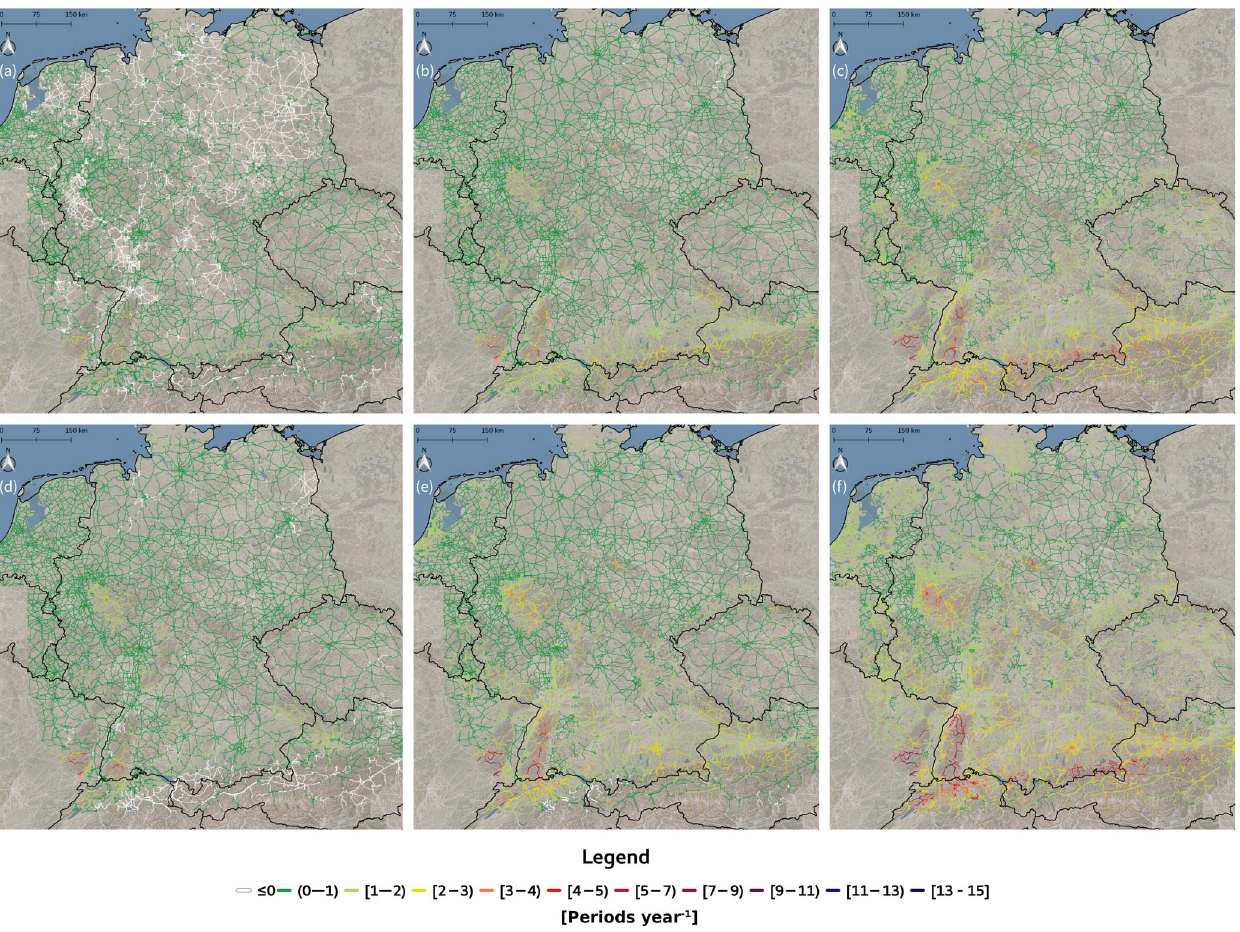
Figure 1. Projected changes in the annual number of periods exceeding rainfall thresholds for the possible occurrence of landslides (precip- itation totals > 25.6mmd − 1 and > 37.3mm(3d) − 1 ) concerning the high-level road network in central Europe. The first row (a–c) shows near-future projection results and the second row (d–f) displays projection results for the remote future. The three columns represent the quartiles in increasing order, with (a) and (d) displaying the lower quartile, (b) and (e) displaying the median and (c) and (f) displaying the upper quartile Table 1. Summary statistics for the six different facets displayed in Figs. 1 and 2 based on all raster cells covering road or rail infrastructure links. Results refer to the relative changes compared to present-day conditions, values indicate the magnitude of changes in the number of periods exceeding the CI